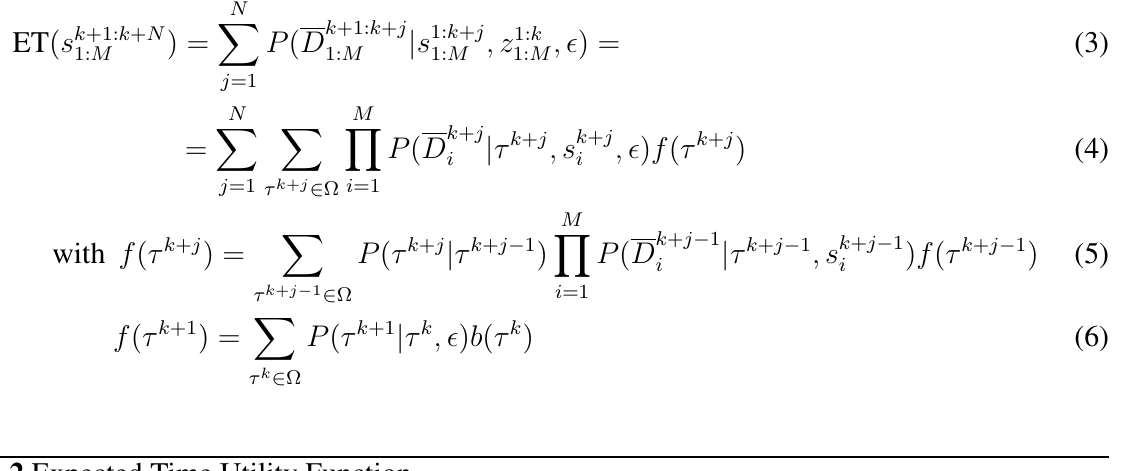
Algorithm 2 Expected Time Utility